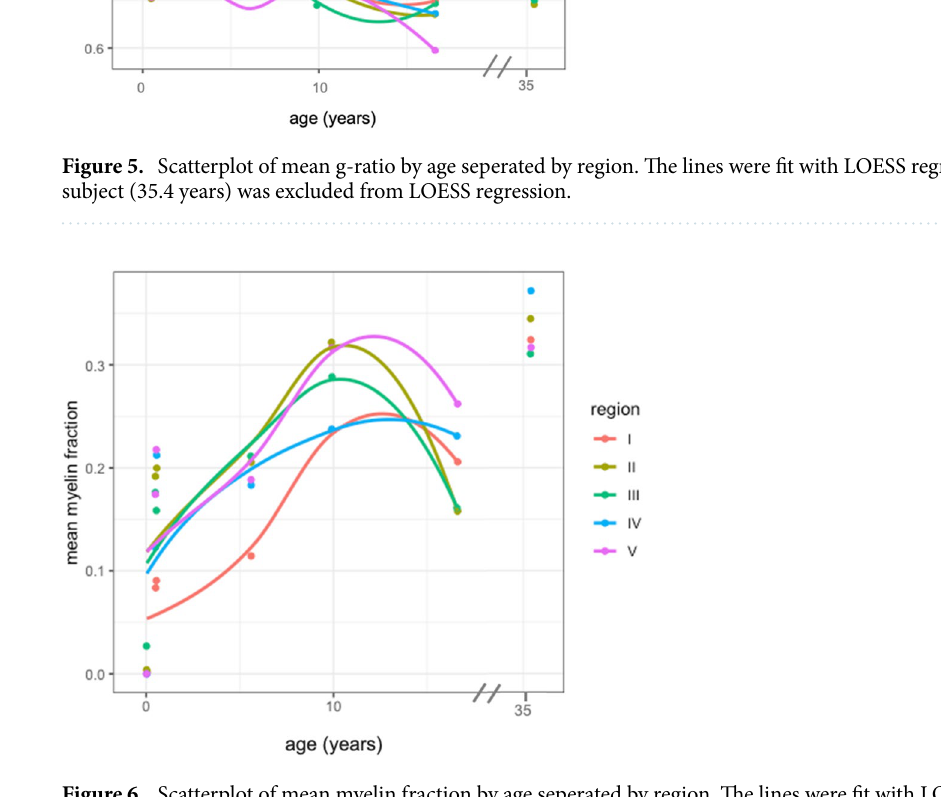
Figure 6. Scatterplot of mean myelin fraction by age seperated by region. The lines were fit with LOESS regression. One subject (35.4 years old) was excluded from LOESS